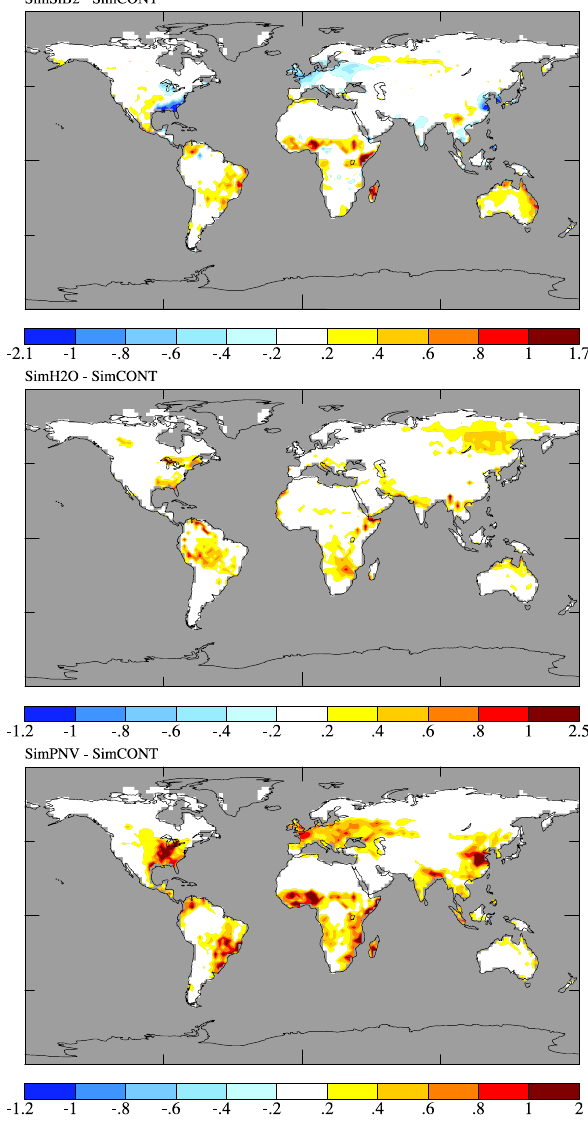
Fig. 2. Difference in simulated annual average isoprene emis- sion relative to the control simulation for an alternative vegeta- tion cover map (top), in the artificial absence of water stress (mid- dle), and for potential natural vegetation cover (bottom). Units aremgCm − 2 h − 1